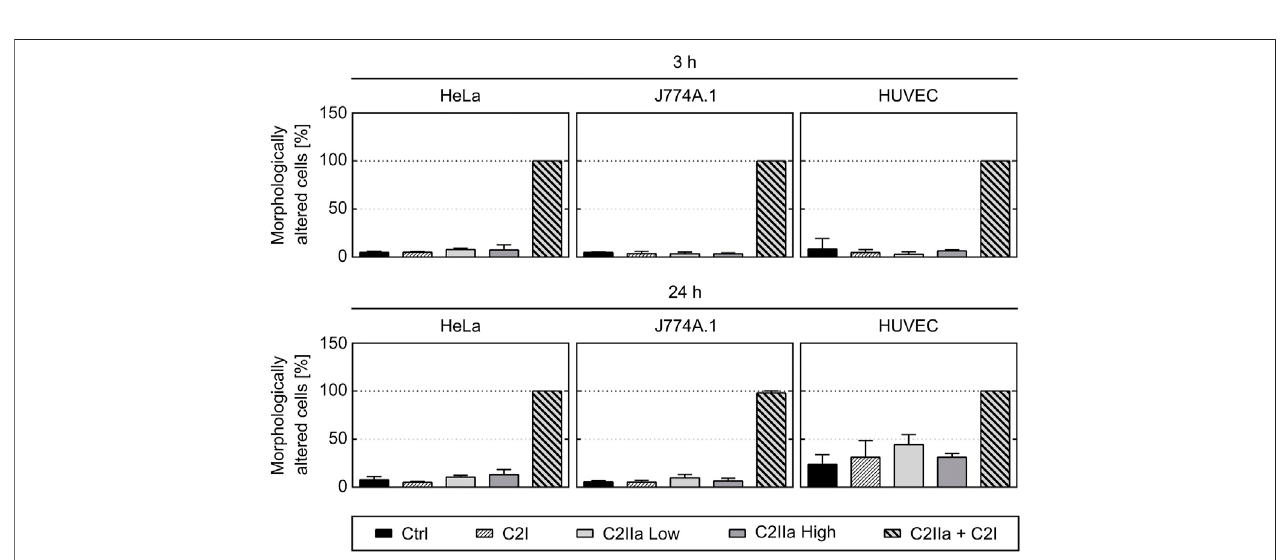
FIGURE 4 | Effect of complete C2 toxin and its single components C2IIa and C2I on the morphology of HeLa, HUVEC and J774A.1 cells. The percentage of morphologically changed cells was quanti fi ed after 3 and 24 h treatment (37 ° C) of different cell types with C2I (1 μ g/ml), C2IIa Low (2 μ g/ml), C2IIa High (5 μ g/ml),